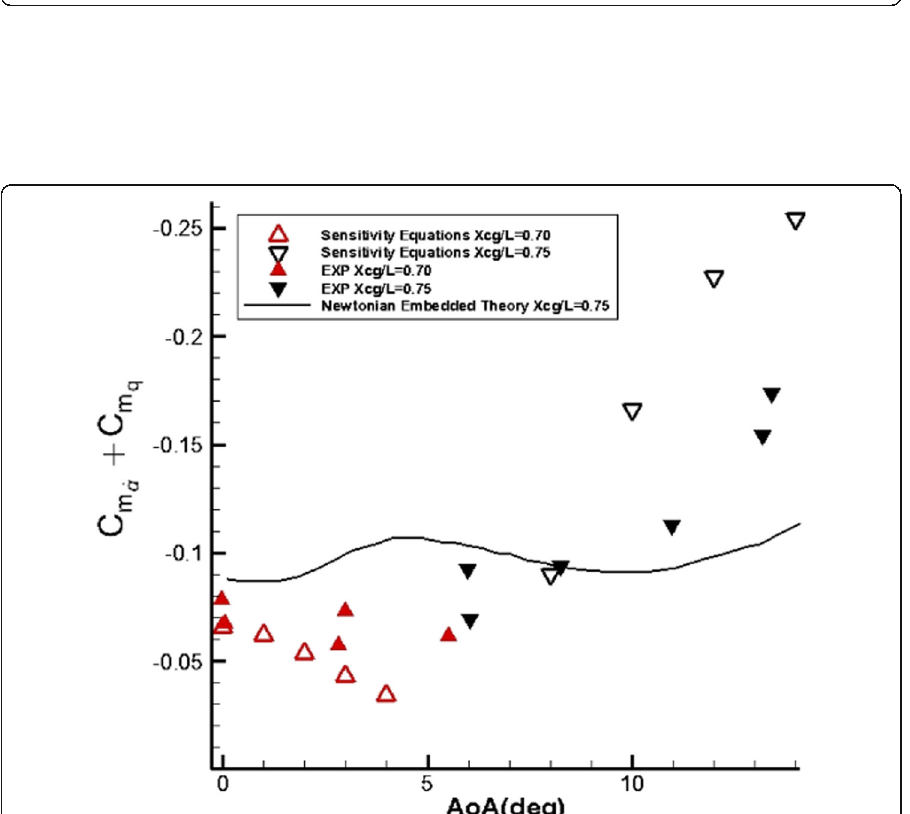
Fig. 10 Comparison of the dynamic moment derivatives between the theoretical, experimental and numerical results after considering the bottom